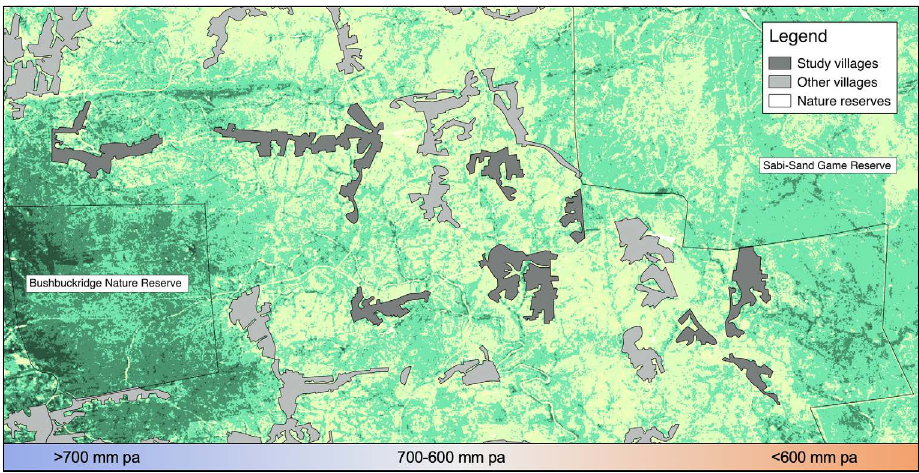
Figure 1: Map of the study site indicating study villages and their environmental context (vegetation cover and position along the rainfall